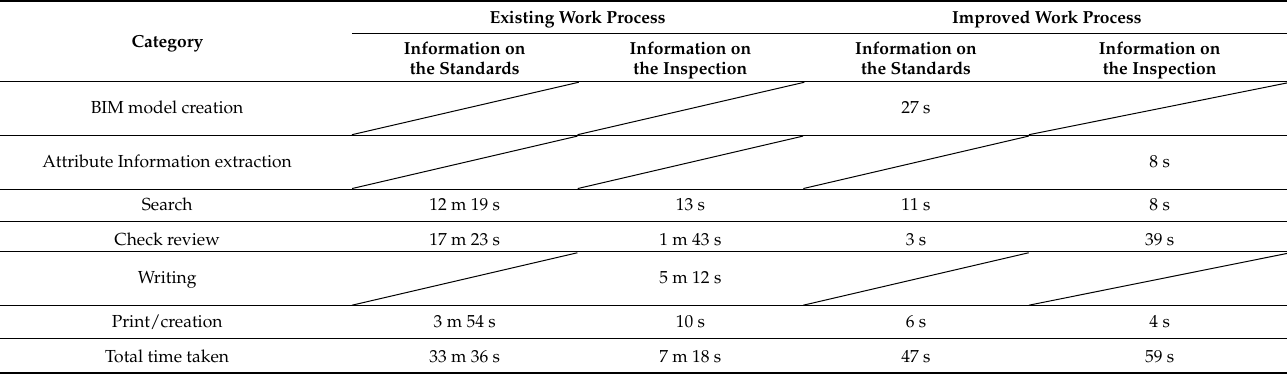
Table 7. Time measurement results by work process for pre-inspection works (first evaluation).